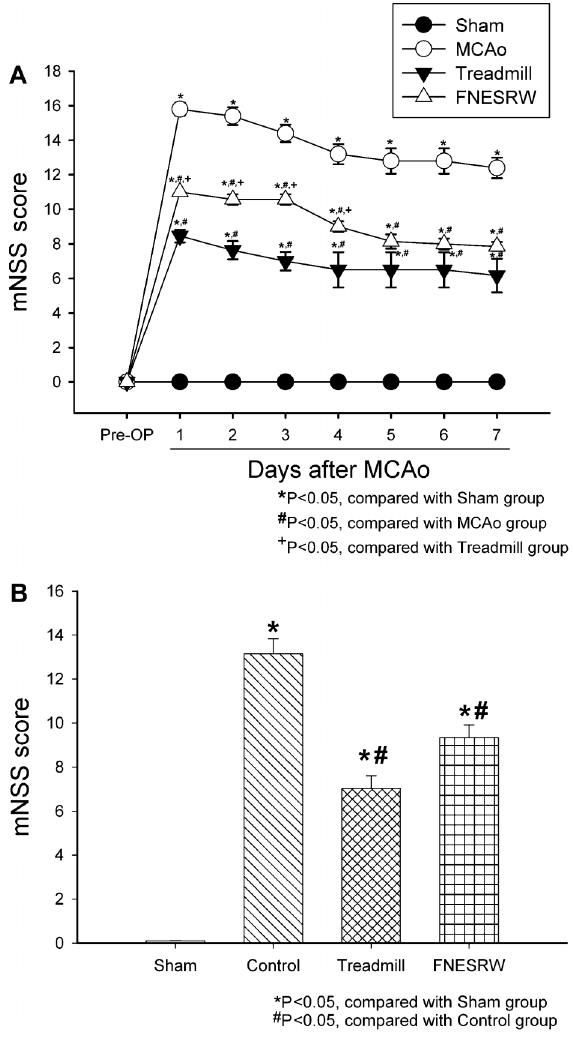
Figure 7. Average modified neurological severity score (mNSS) for the three groups over a period of 7 days. A , Daily average mNSS values. B , Average mNSS values for 7 days (means±SD). FNESRW:forcednon-electric-shock runningwheel;MCAo:middle cerebral artery occlusion. Analysis of variance showed a sig- nificant difference (P , 0.05), with an F-value of 139.532 for 3 and 32 degrees of